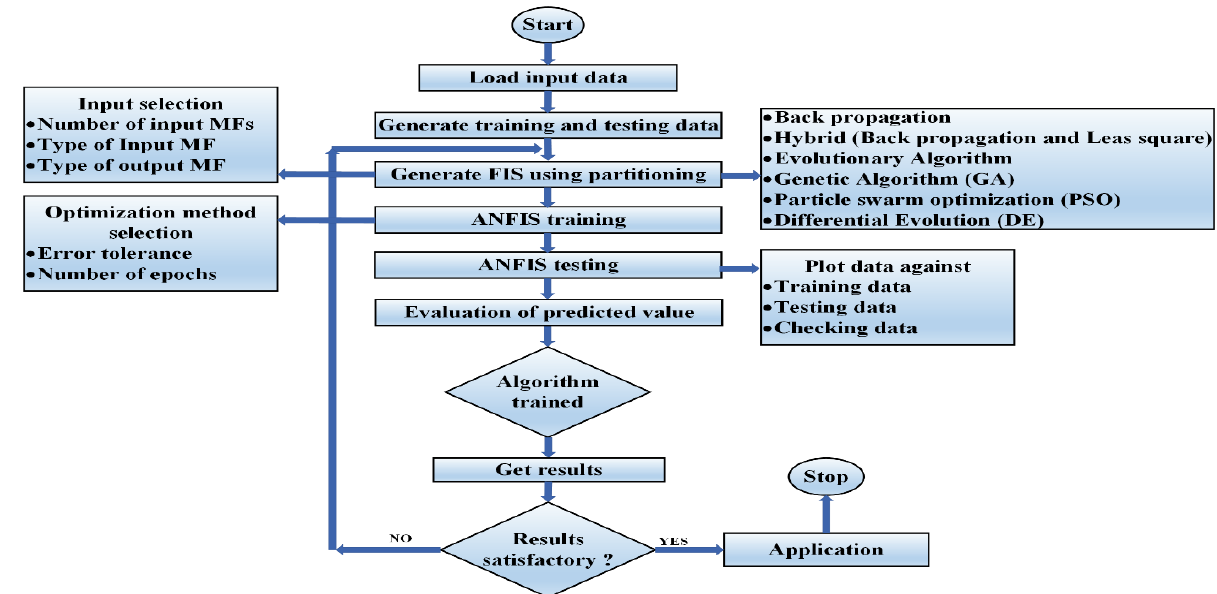
Figure 10. The procedure flowchart of ANFIS.